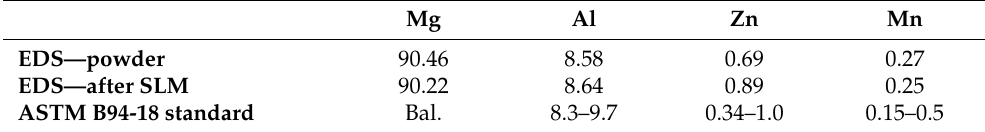
Table 9. Results of EDS chemical analysis of the material before and after the SLM process [wt.%].